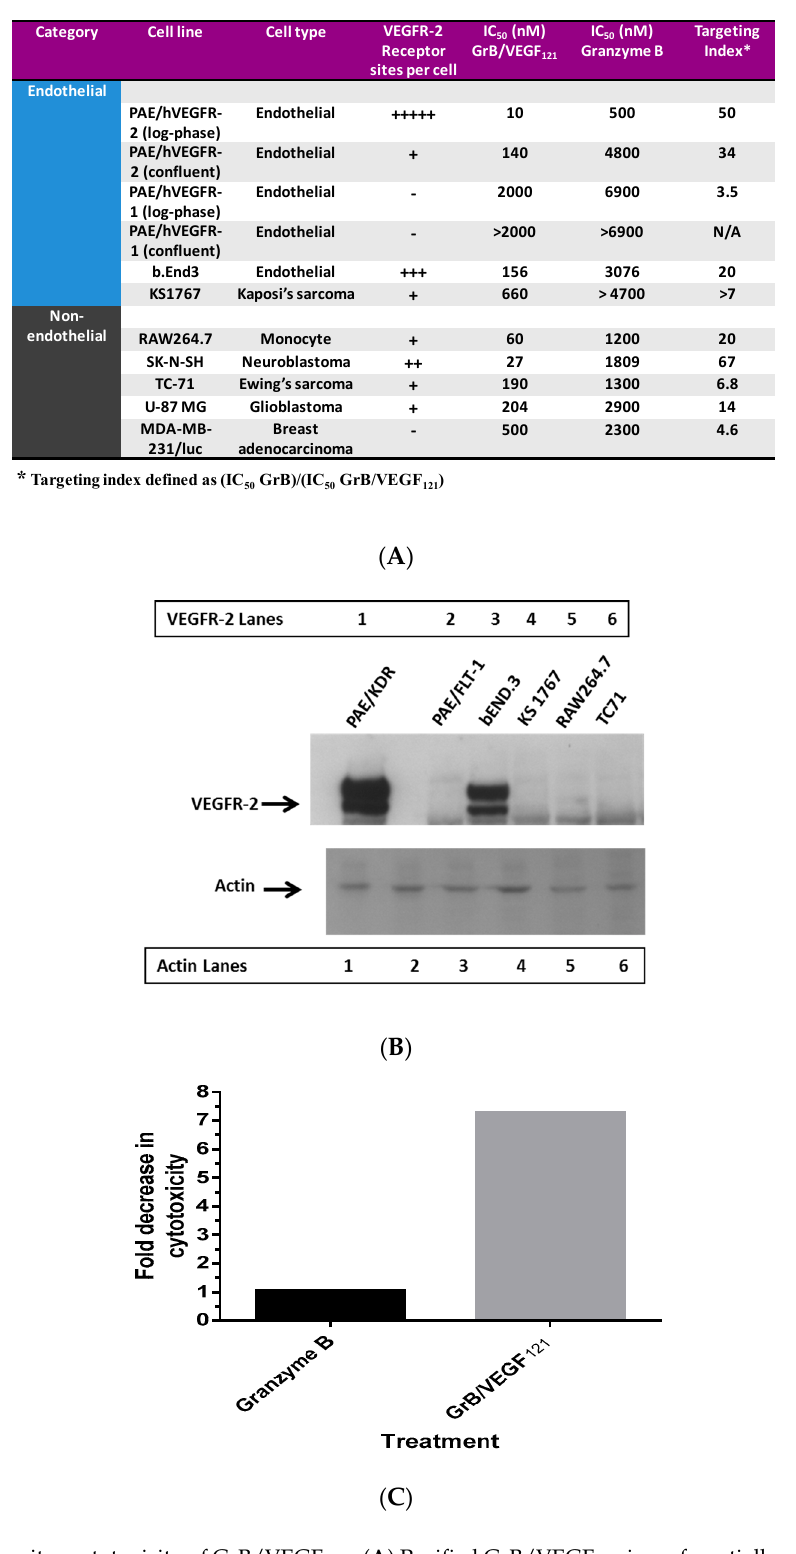
Figure 2. In vitro cytotoxicity of GrB/VEGF 121 . ( A ) Purified GrB/VEGF 121 is preferentially cytotoxic to log-phase endothelial cells that over-express VEGFR-2. Other cells, such as the neuroblastoma cell line SK-N-SH and the glioblastoma cell line U87-MG, are also sensitive. ( B ) Expression levels of VEGFR-2 in some of the cell lines tested indicate some relationship between VEGFR-2 levels and sensitivity to GrB/VEGF 121 . ( C ) The impact on cytotoxicity upon pre-incubation of cells with 1 µM VEGF 121 .